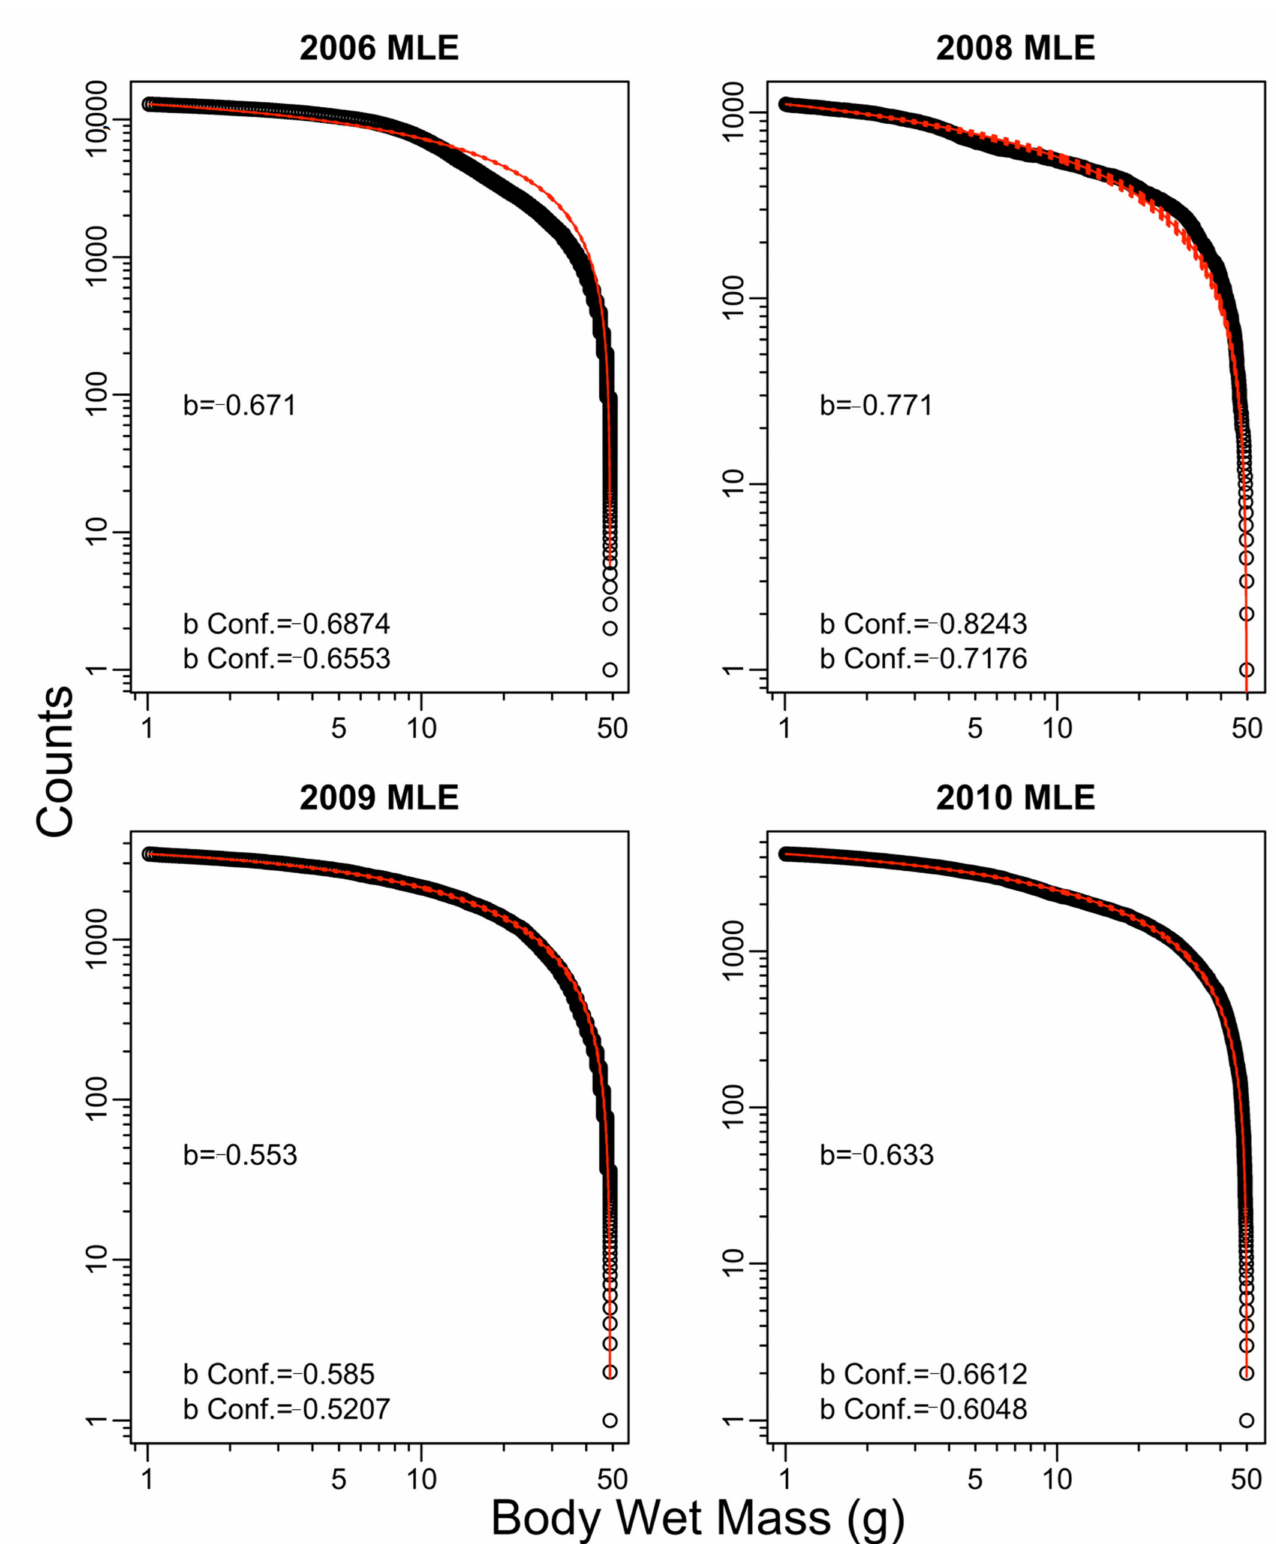
Figure A4. Fish SS with counts and body wet mass (g) fitted using the maximum likelihood estimate of exponent b with the 95% confidence interval of b based on SEDs from hydroacoustic surveys for